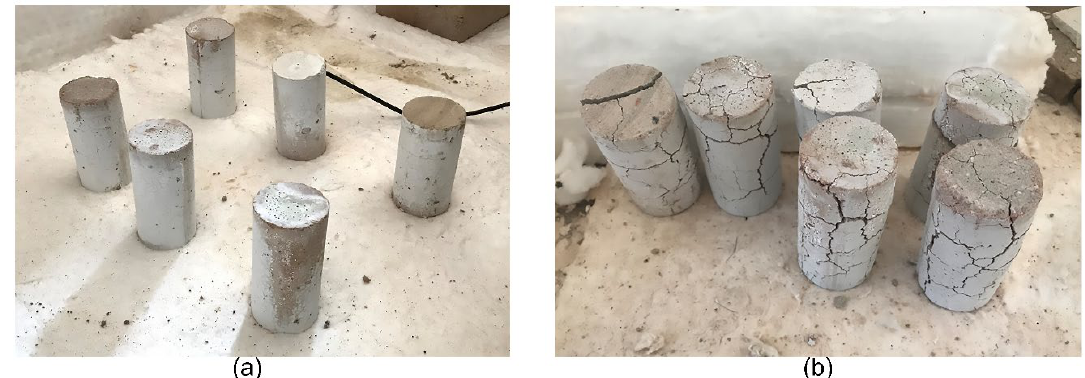
Figure 11. Bedding mortar specimens (a) one day after the test and (b) seven days after the